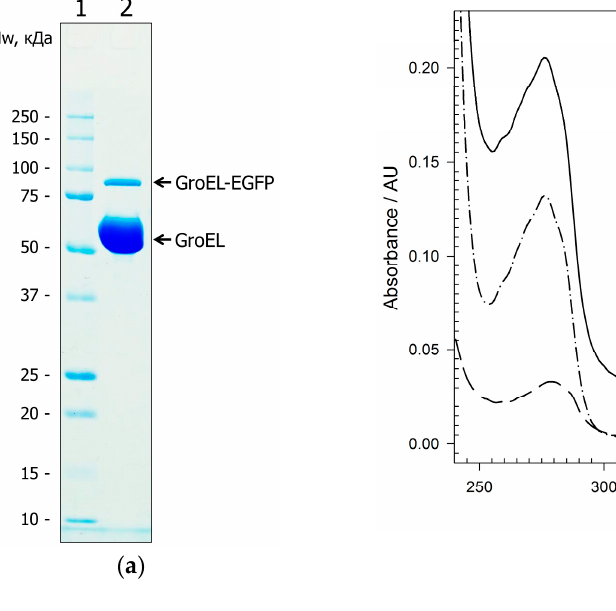
Figure 2. An estimation of the amount of fusion protein GroEL 1 -EGFP incorporated in tetradecamer GroEL 14 particle: ( a ) SDS-PAGE electrophoresis of the GroEL 14 -EGFP population (Lane 2). The intensity of the WT GroEL subunit band is 9.69 relative units while that of the fusion GroEL 1 -EGFP is 1. Molecular-weight markers (Lane 1). ( b ) Absorption spectra of the GroEL 14 -EGFP population (black solid line), monomeric fusion GroEL 1 -EGFP (black dashed line, absorbance at 489 nm is A 489nm = 0.06 absorbance units (AU), concentration of the protein is C = 1.07 µM). The absorption spectrum of WT GroEL 14 subunits (black dashed-dot line) was obtained by subtraction of the GroEL 1 -EGFP spectrum from the spectrum of the GroEL 14 -EGFP population after their normalization at 499 nm (EGFP absorption) with a negligible contribution of the light scattering, and by the correction for light scattering, A 280nm = 0.12 AU, C = 14.3 µM.